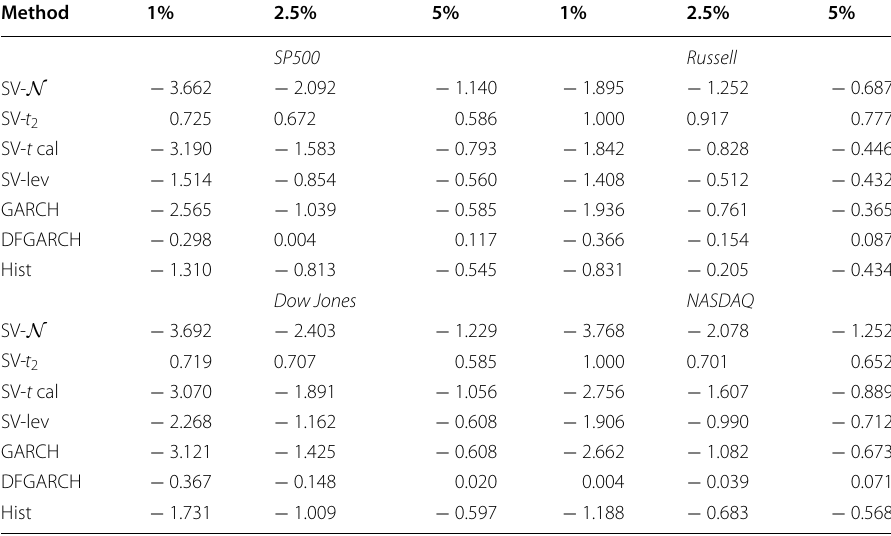
Table 1 Backtesting results based on Z